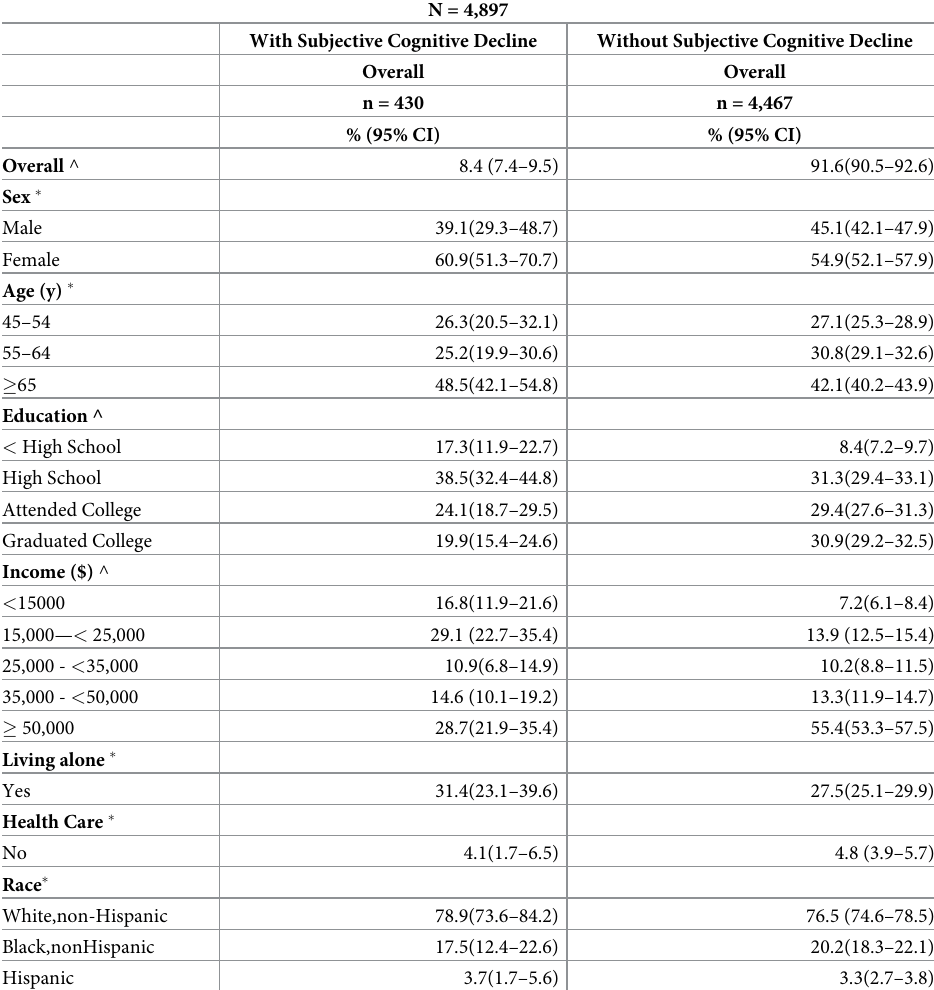
Table 1. Demographic Characteristics of Delaware Adults Aged 45 Years or Older by Subjective Cognitive Decline (SCD) Status, Behavioral Risk Factor Surveillance System (Combined 2016 and 2020). N = 4,897 With Subjective Cognitive Decline Without Subjective Cognitive Decline Overall Overall n = 430 n = 4,467 % (95% CI) Overall